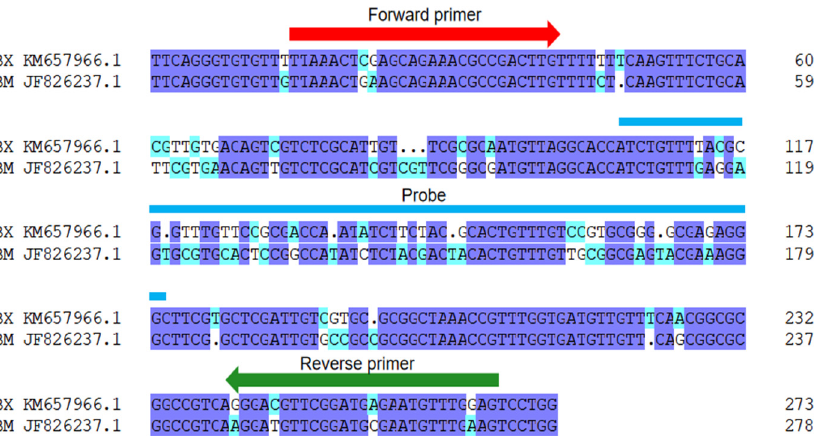
Figure 2. Nucleotide sequence alignment of the ITS2 genes from B. xylophilus (BX) and B. mucronatus (BM). The locations of the probe and forward and reverse primers are marked by blue, red and green boxes, respectively.